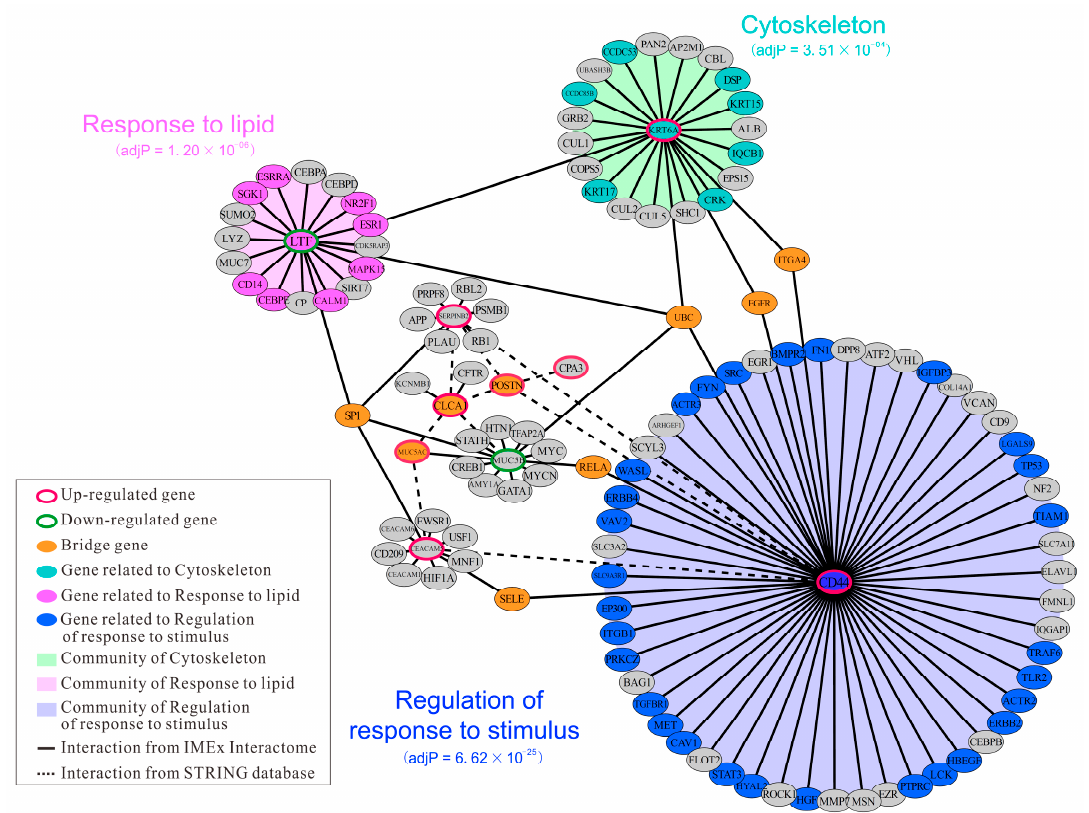
Figure 6. Protein-protein interaction network associated with asthma was constructed based on the DEGs with fold change > 1.5. The up- and down-regulated DEGs are marked in red and green circles, respectively. The solid lines and dashed lines represent the interactions predicted based on the IMEx interactome database and STRING database (v11.0), respectively. According to the degree of each node, six proteins with degree ≥ 10 were regarded as the hub proteins, and their corresponding genes were thought to be the hub genes, including CD44 (degree = 59), KRT6A (degree = 23), LTF (degree = 18), MUC5B (degree = 13), CEACAM5 (degree = 11), and SERPINB2 (degree = 10).